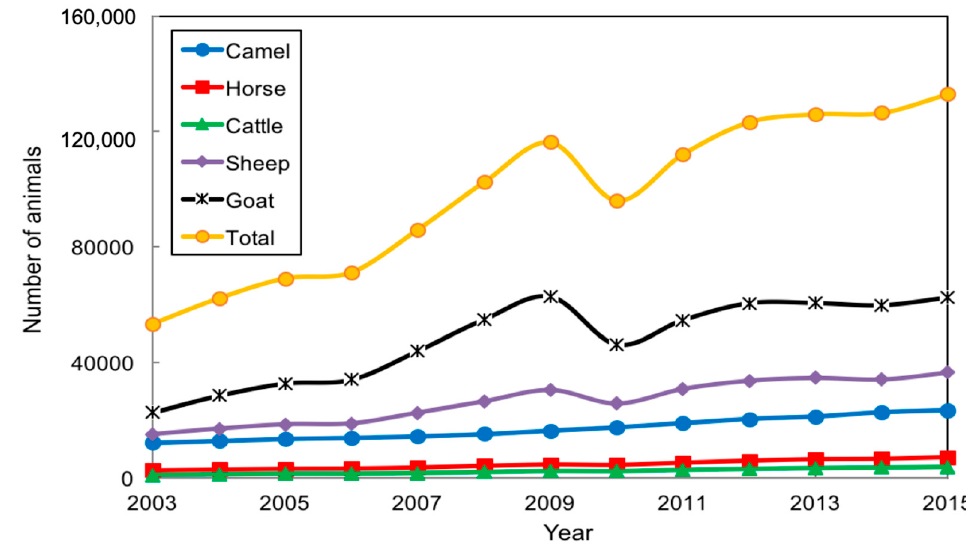
Figure 5. Change in numbers of animals kept by herders in Khanbogd soum , from 2003–2015 [49]. The impact of OT varied with potentially negative and positive outcomes. The